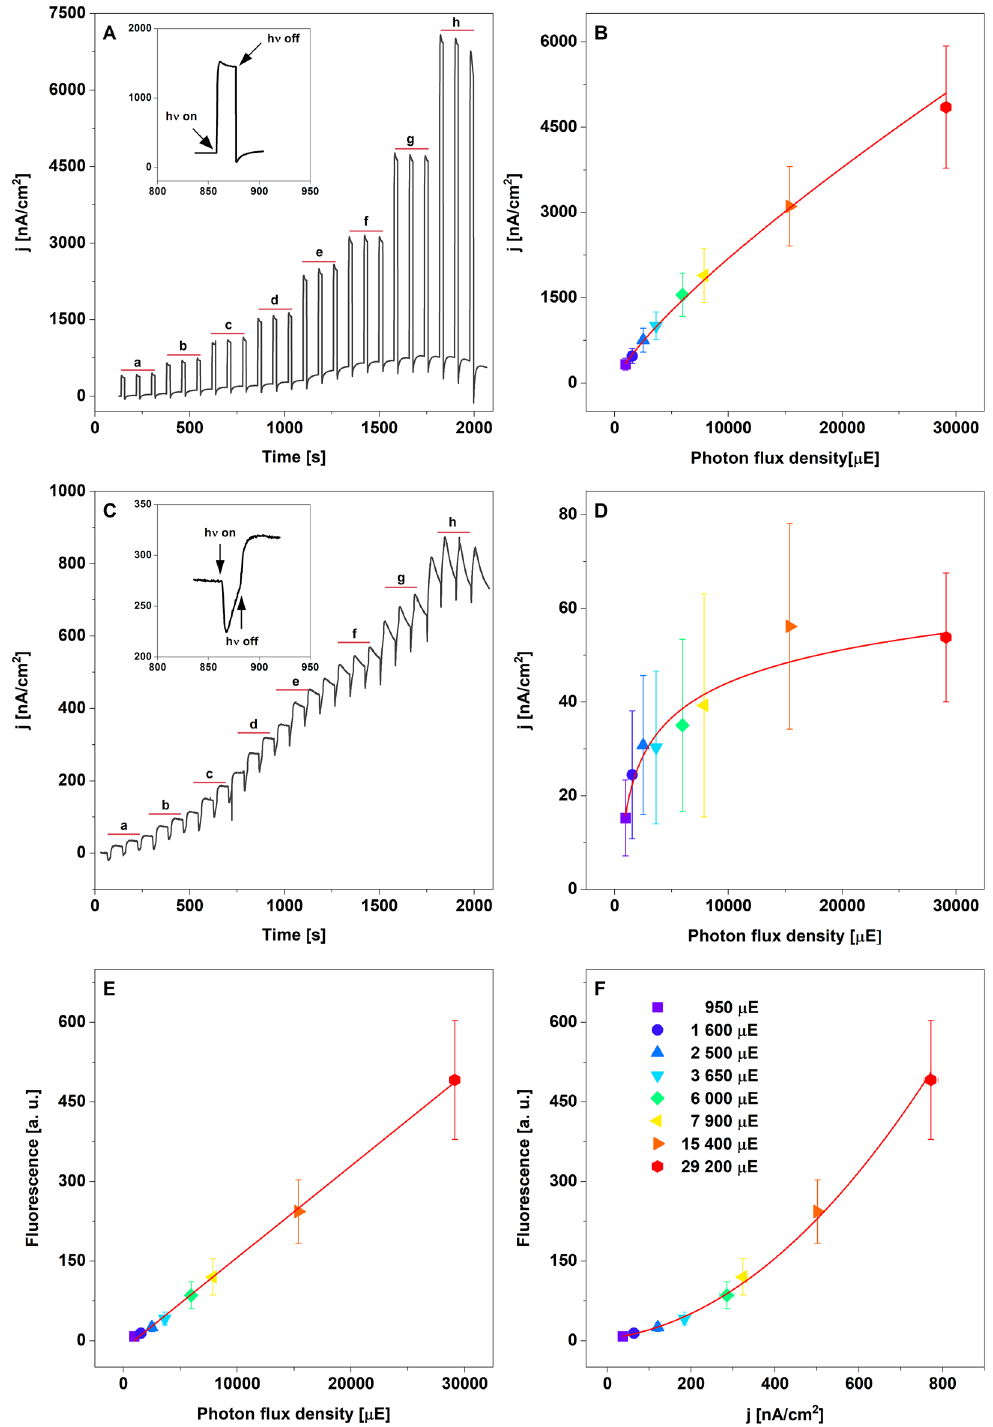
Figure 2. Response of GE-LHCII 3 -PPBQ and GE-PPBQ systems to a gradual increase of light intensity. Panels A and C show the changes of current under the dark/light cycle, where the insets ( A , C ) show the turned points for these cycles (20 s light/60 s dark). Panels B and D present the relation between anodic and cathodic current density and photon flux density (PFD) for GE-LHCII 3 -PPBQ and GE-PPBQ, respectively. In panels E and F the relationship of fluorescence and current density, respectively versus PFD for GE-LHCII 3 -PPBQ were calculated. The actinic white-light was used for induction of anodic ( A , B ) and cathodic ( C , D ) photocurrents whereas for the simultaneous induction of Chl fluorescence and anodic photocurrent the actinic blue-light was used ( E , F ). The letters (a–h) in panels A and B indicate the actinic light intensity from 950 (a) to 29 200 µE (h), in the order presented in panel F . The non-linear fitting curves were calculated for average data (solid red lines). The data are mean values ± SD for 5 independent